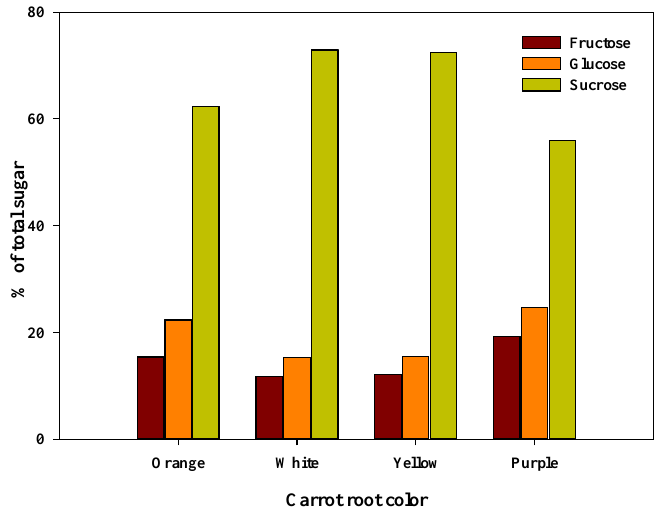
Figure 3. Individual free sugar content (%) in orange, white, yellow and purple colored carrot genetic resources.